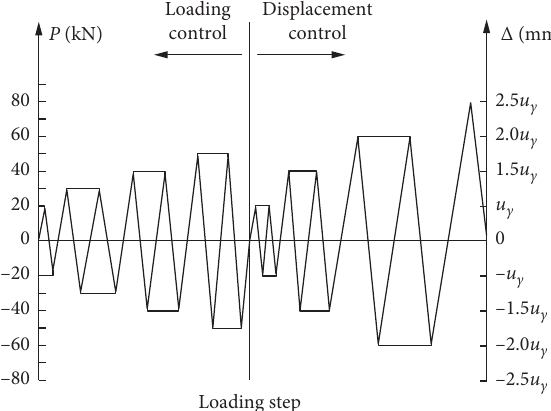
Figure 3: Loading